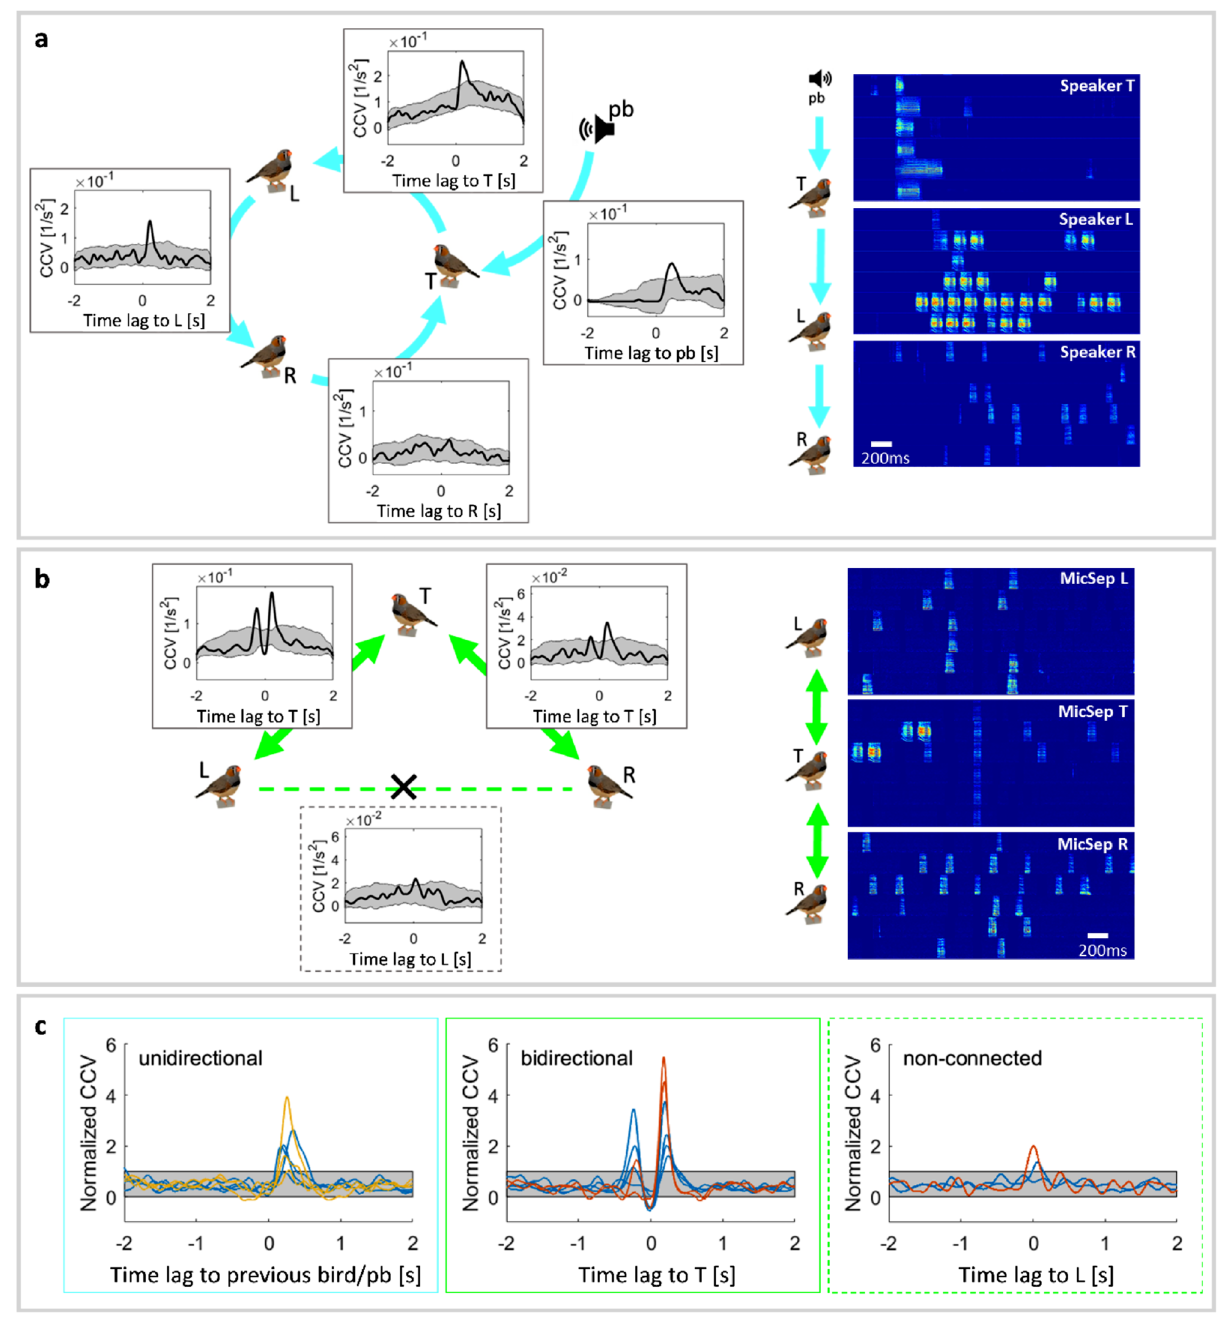
Figure 7. The structure of vocal interactions mirrors that of the imposed network. ( a ) In an asymmetric network, the interactions tend to be asymmetric, and ( b ) in a symmetric network, they tend to be symmetric. ( a ) In pairs of asymmetrically connected birds, cross-covariance (CCV) functions (black lines, see “Technical details”) indicate unidirectional vocal exchanges revealed by unimodal peaks. Stacks of example spectrograms are shown (right) with the auditory stimulus (pb) presented in chamber T (top), T’s response broadcast to bird L (middle), and L’s response broadcast to R (bottom); corresponding rows in the 3 sub-panels are from simultaneous recordings. ( b ) In a symmetric hierarchical network, CCV functions reveal bidirectional vocal interactions. ( a , b ) The gray areas represent 3 standard deviations of a random shuffle predictor (see “Technical details”). ( c ) Normalized CCV functions in unidirectional (left), bidirectional (middle), and non-connected (right) bird pairs, n = 3 bird groups (blue in all 3 subpanels, orange in the middle and right subpanel, and yellow in the left subpanel) across a total of 5 different network configurations (two asymmetric, three symmetric). To allow for comparison among experiments, CCV functions were normalized by the shuffle predictor (gray areas; see “Technical details”), which sets the threshold for statistical significance at a fixed unit distance along the y